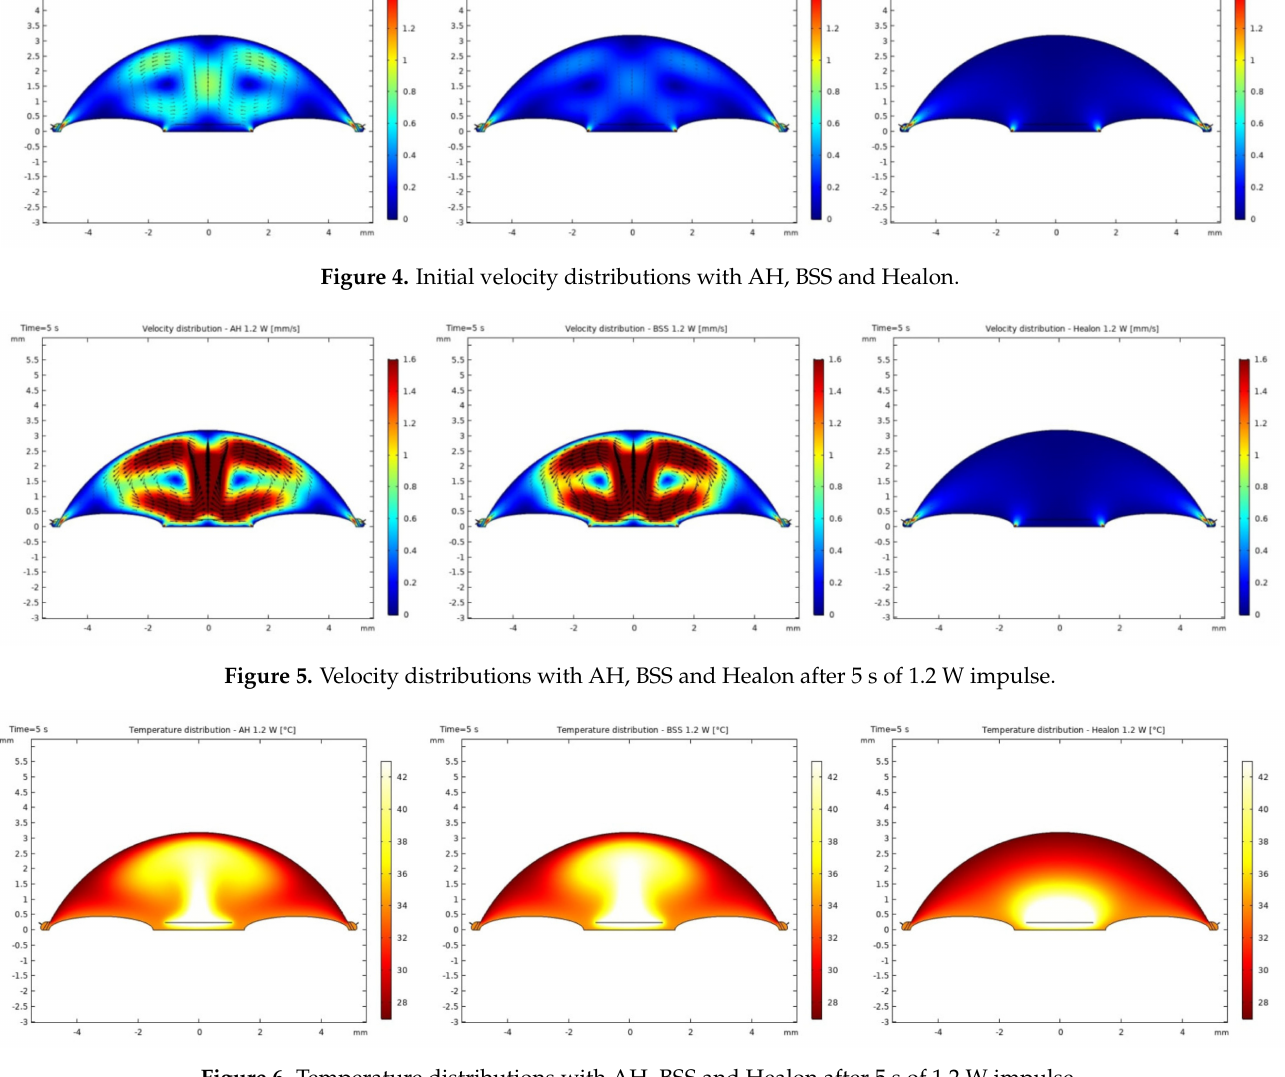
Figure 6. Temperature distributions with AH, BSS and Healon after 5 s of 1.2 W